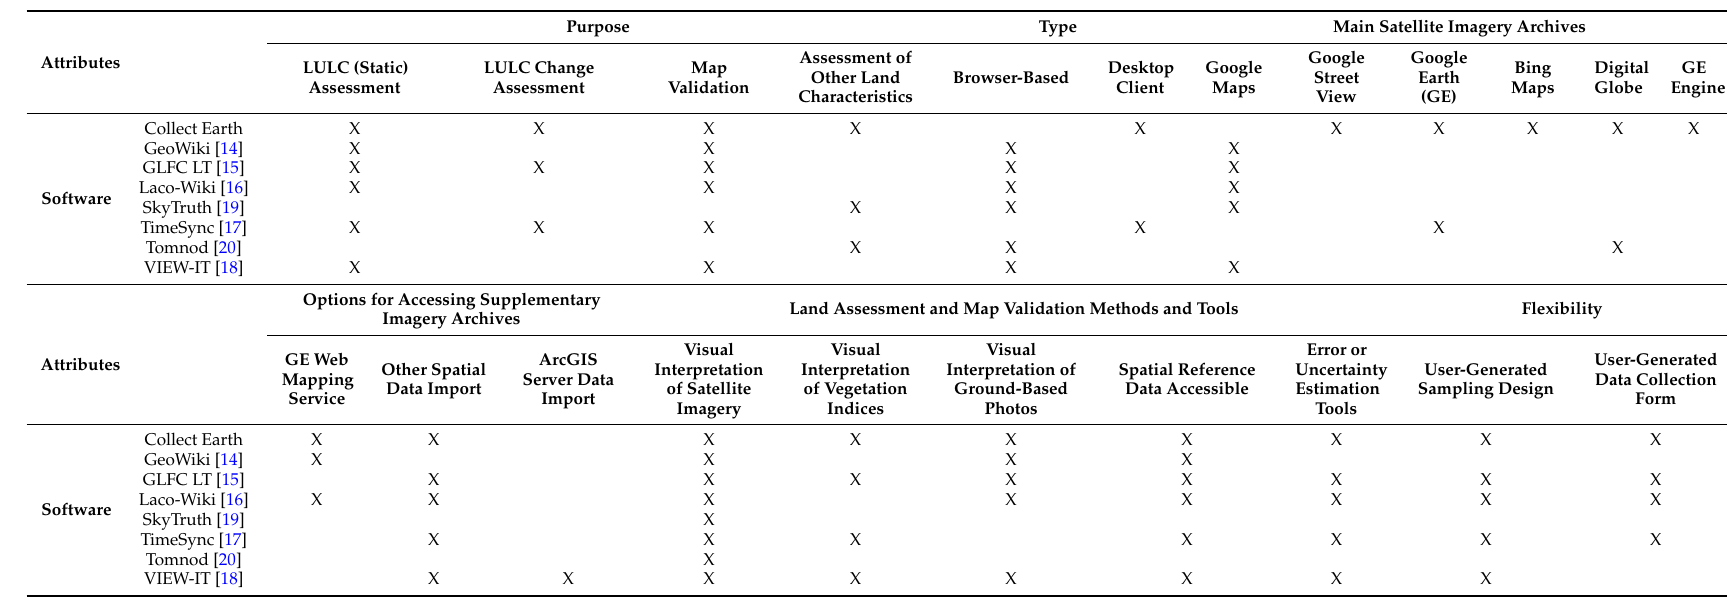
Table 1. Overview of relevant existing free land assessment